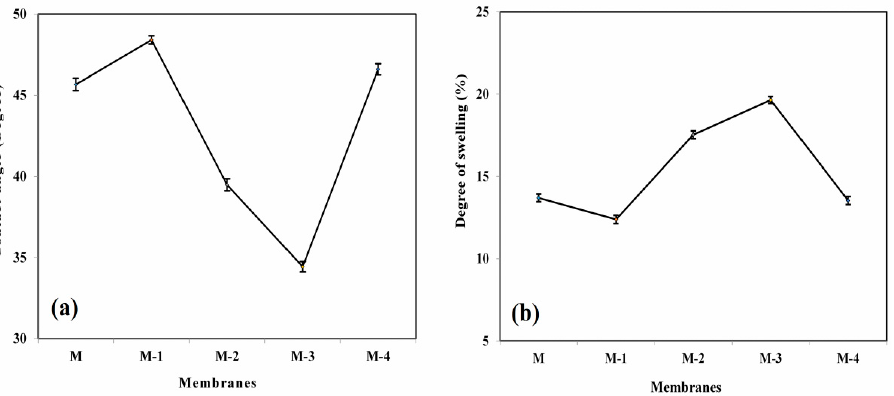
Figure 5. ( a ) Contact angle; ( b ) degree of swelling values of NaCMC, and its Ge-incorporated PECM membranes; (M) 0 mass%; (M-1) 5 mass%; (M-2) 10 mass%; (M-3) 15 mass%; (M-4) 20 mass% of Ge.